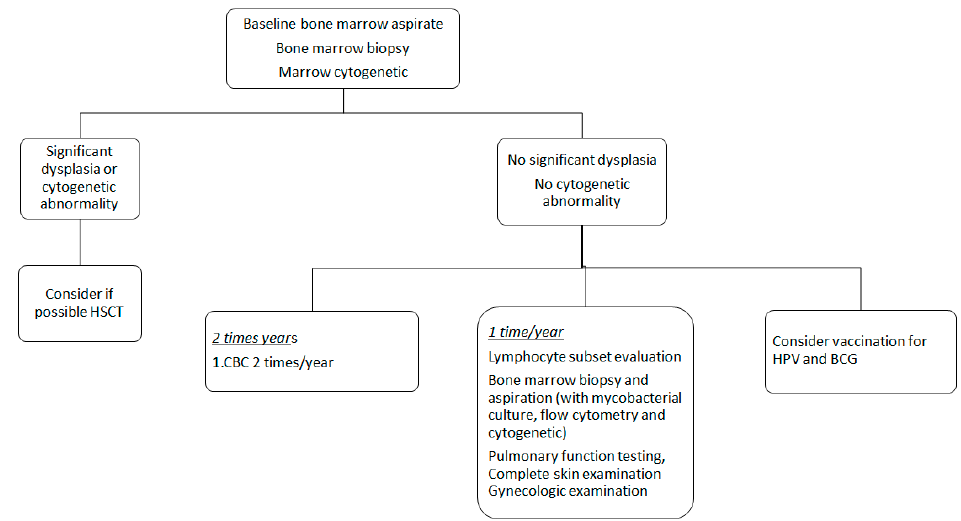
Figure 2. Possible algorithm for management of patients with GATA2 deficiency.